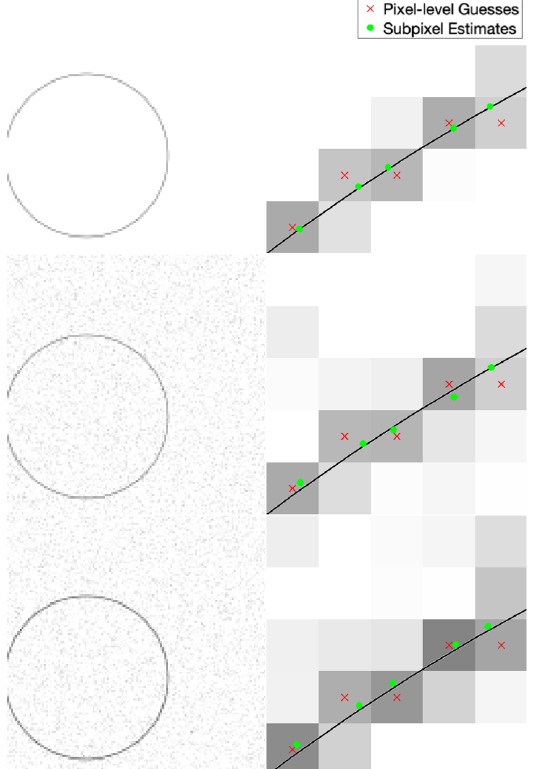
Figure 9. Qualitative visualization of subpixel streak localization performance at varying levels of blur and SNR. The left column shows the full synthetically generated image and the right column shows a small area within that image. The rows represent different noise and blur levels (top: no noise or blur; middle: noise only(approximately 28.5 peak signal to noise ratio); bottom: noise and blur (2D Gaussian kernel with standard deviation of 0.3 pixels)). The black line is the exact location of the true streak